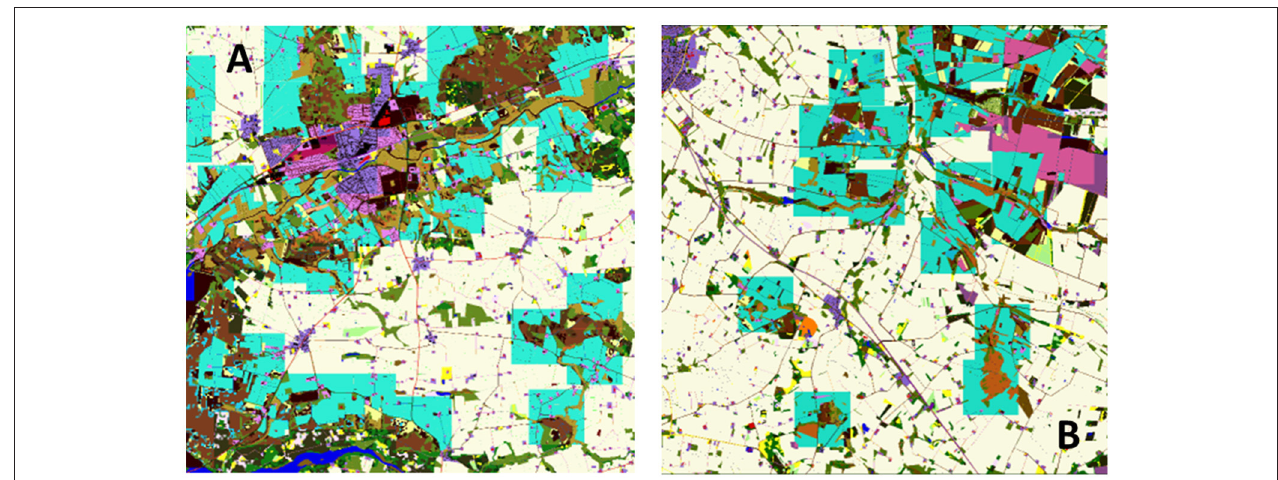
FIGURE 2 | Example predator territory locations (overlay in blue) in two 10 × 10 km landscape maps, Bjerringbro (A) and Herning (B) for M. nivalis . In this case territories are clustered around semi-natural landscape elements and avoid town areas and open country. The territories are represented as squares of a minimum size required to achieve the minimum territory score based on the area of underlying habitats.